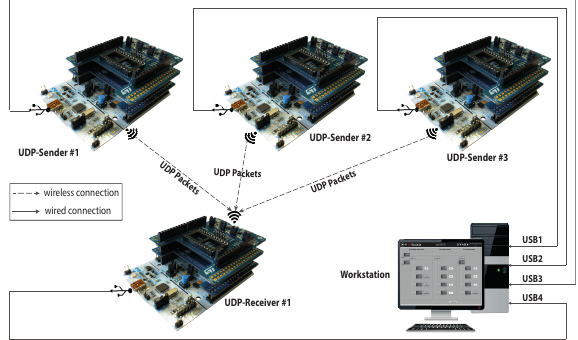
Figure 8. Considered application using ContikiMAC RDC.